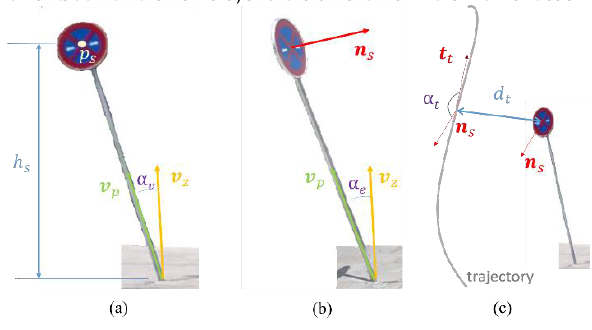
Figure 3. Geometric inventory. Different parameters can be extracted using the point cloud data (a) Front view of the traffic sign. (b) Lateral view of the traffic sign. (b) Contextual features using the trajectory. image is taken, which is synced with the 3D point cloud. The usage of 2D images is motivated by the aforementioned insufficient resolution of laser scanners for the traffic sign recognition task.